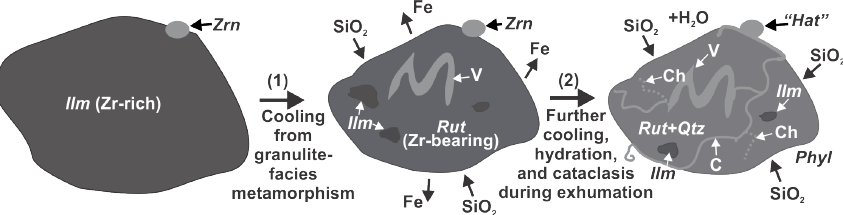
Figure 6. Sketch of the formation stages of zircon coronae. Post-peak metamorphic Zr-rich ilmenite fills the pocket between peak meta- morphic minerals and has lobate boundaries. During the initial retrograde cooling (1) it decomposes to Zr- and SiO 2 -bearing rutile and vermicular-shaped zircon aggregates. The system loses Fe and requires SiO 2 from the surrounding phases; the volume of Fe–Ti oxide decreases. Further cooling, hydration and cataclasis during exhumation (2) results in recrystallization of Zr-bearing rutile to rutile–quartz intergrowths with precipitation of thin zircon coronae. At this point the reaction requires SiO 2 and aqueous fluid from the surroundings. Abbreviations as in Figs. 1, 3 and